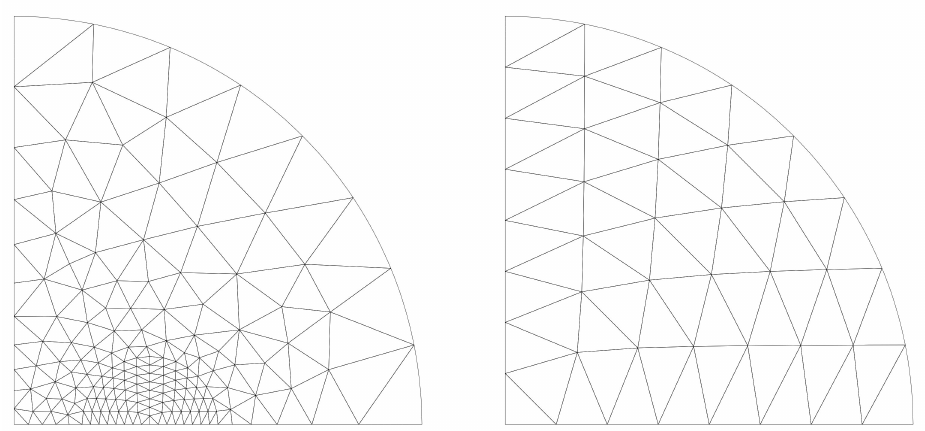
Figure 8. Finite element mesh in the interior and exterior regions in the FEM-CT